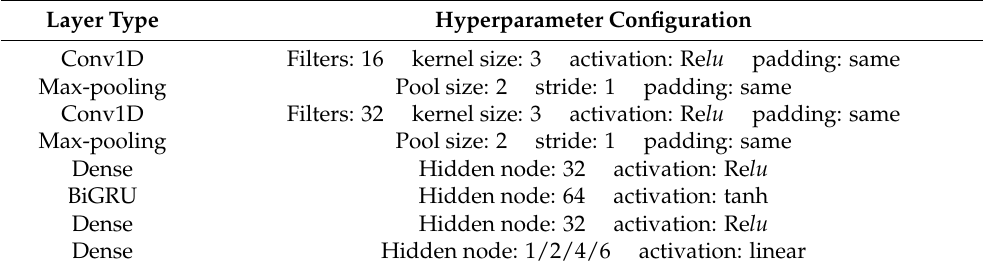
Table 3. Hyperparameter configuration of each layer in the proposed CNNBiGRU model.